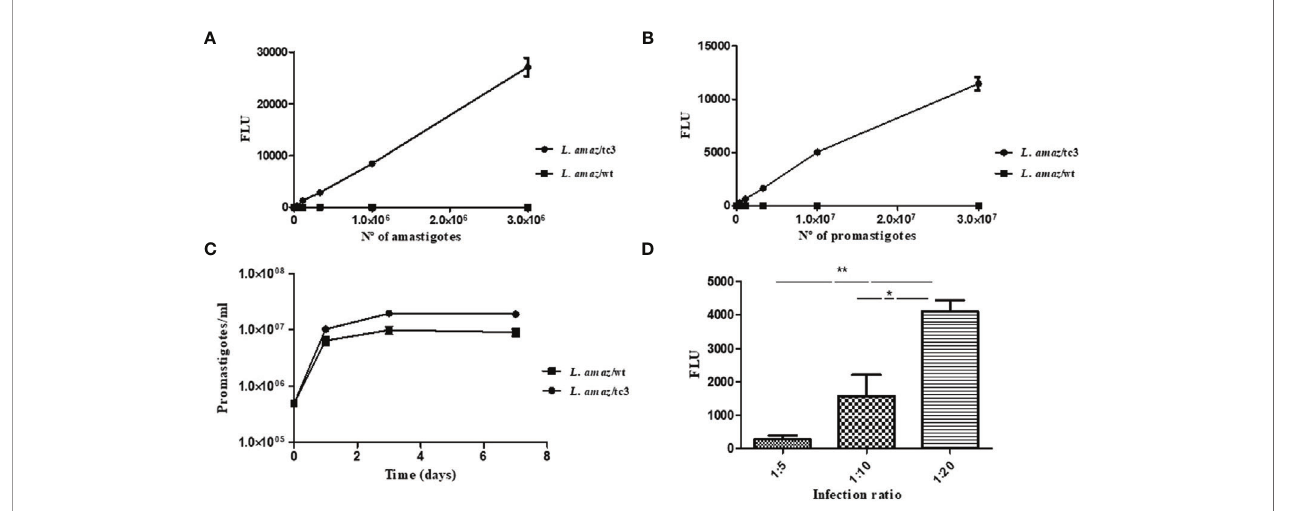
FIGURE 2 | Correlation between the fl uorescence signal and the number of amastigotes (A) and promastigotes of L. amaz /tc3 (B) . (C) No statistical differences were observed between the curve of growth of L. amaz /tc3 and L. amaz /wt, indicating that transfection with the RG did not modi fi ed the normal parasite growth. (D) The fl uorescence signal of intracellular amastigotes of L. amaz /tc3 increased reaching the peak at the second day post-infection, and it was higher in macrophages infected with the ratio 1:20 than 1:5 and 1:10. Statistical signi fi cance was assessed using ANOVA (* p < 0.05 and ** p <